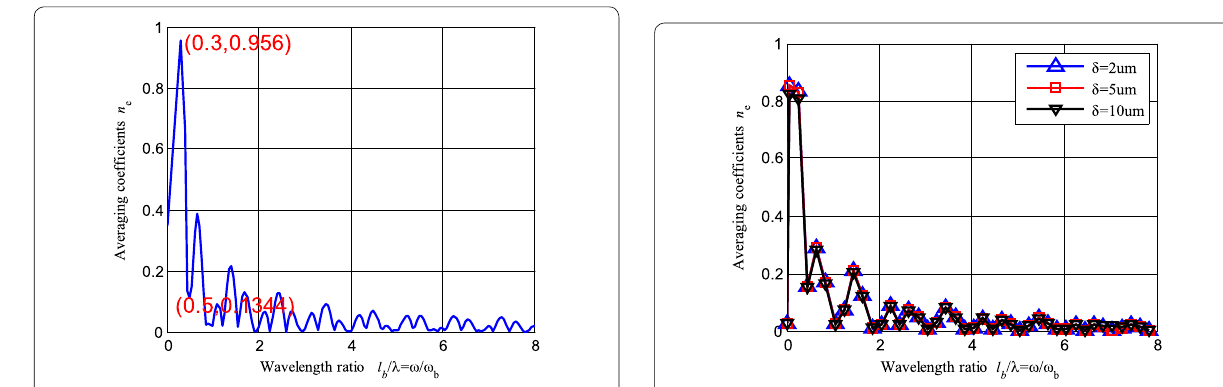
Figure 13 Averaging coefficient curves for different